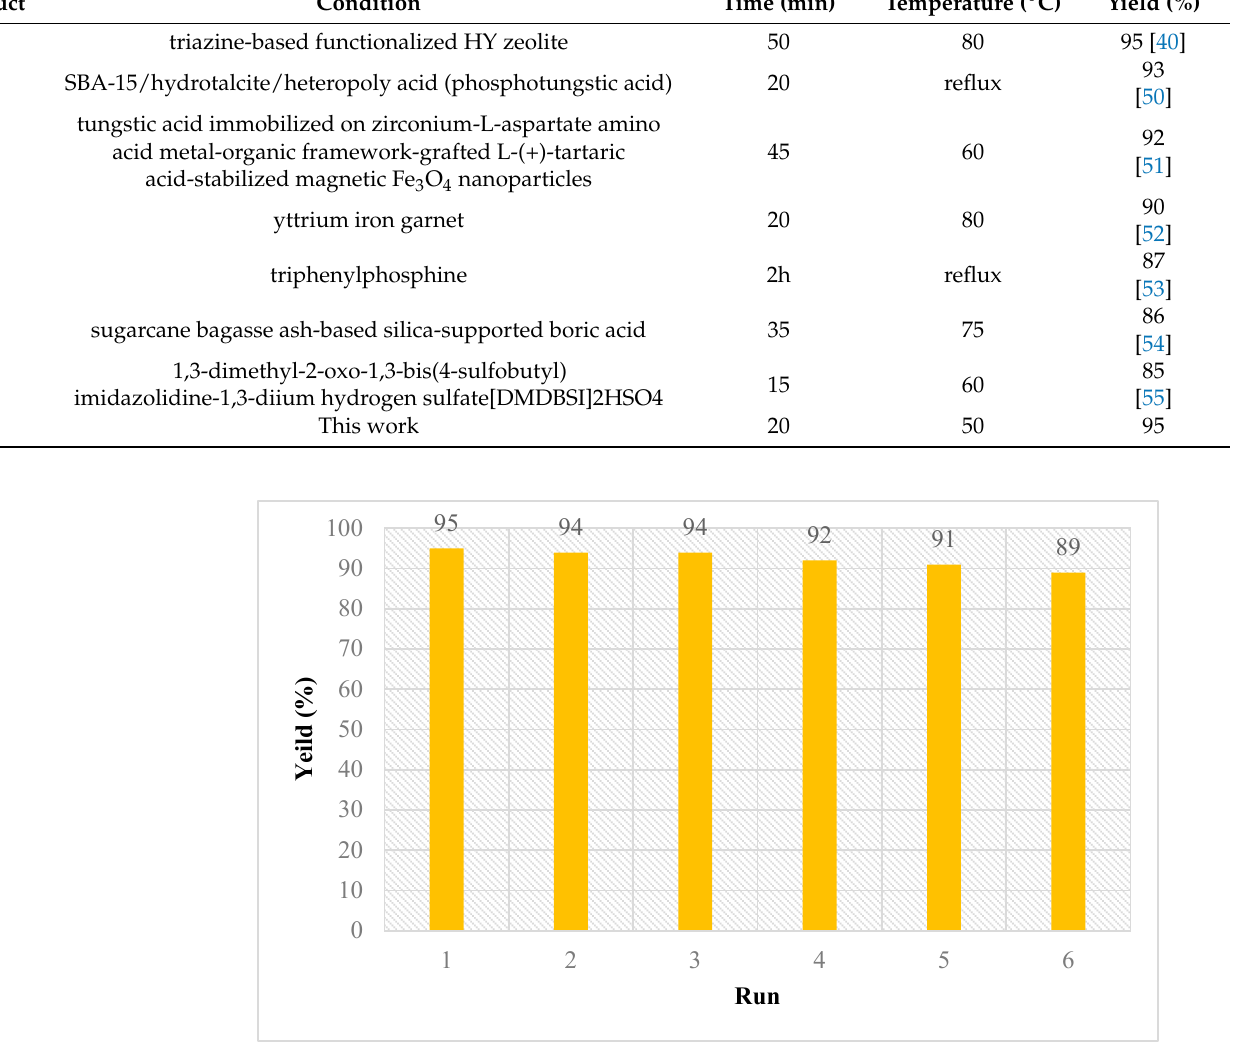
Table 4. Results of antibacterial and antifungal activity of zirconium magnetic nanocomposite com- pared to commercial drugs.